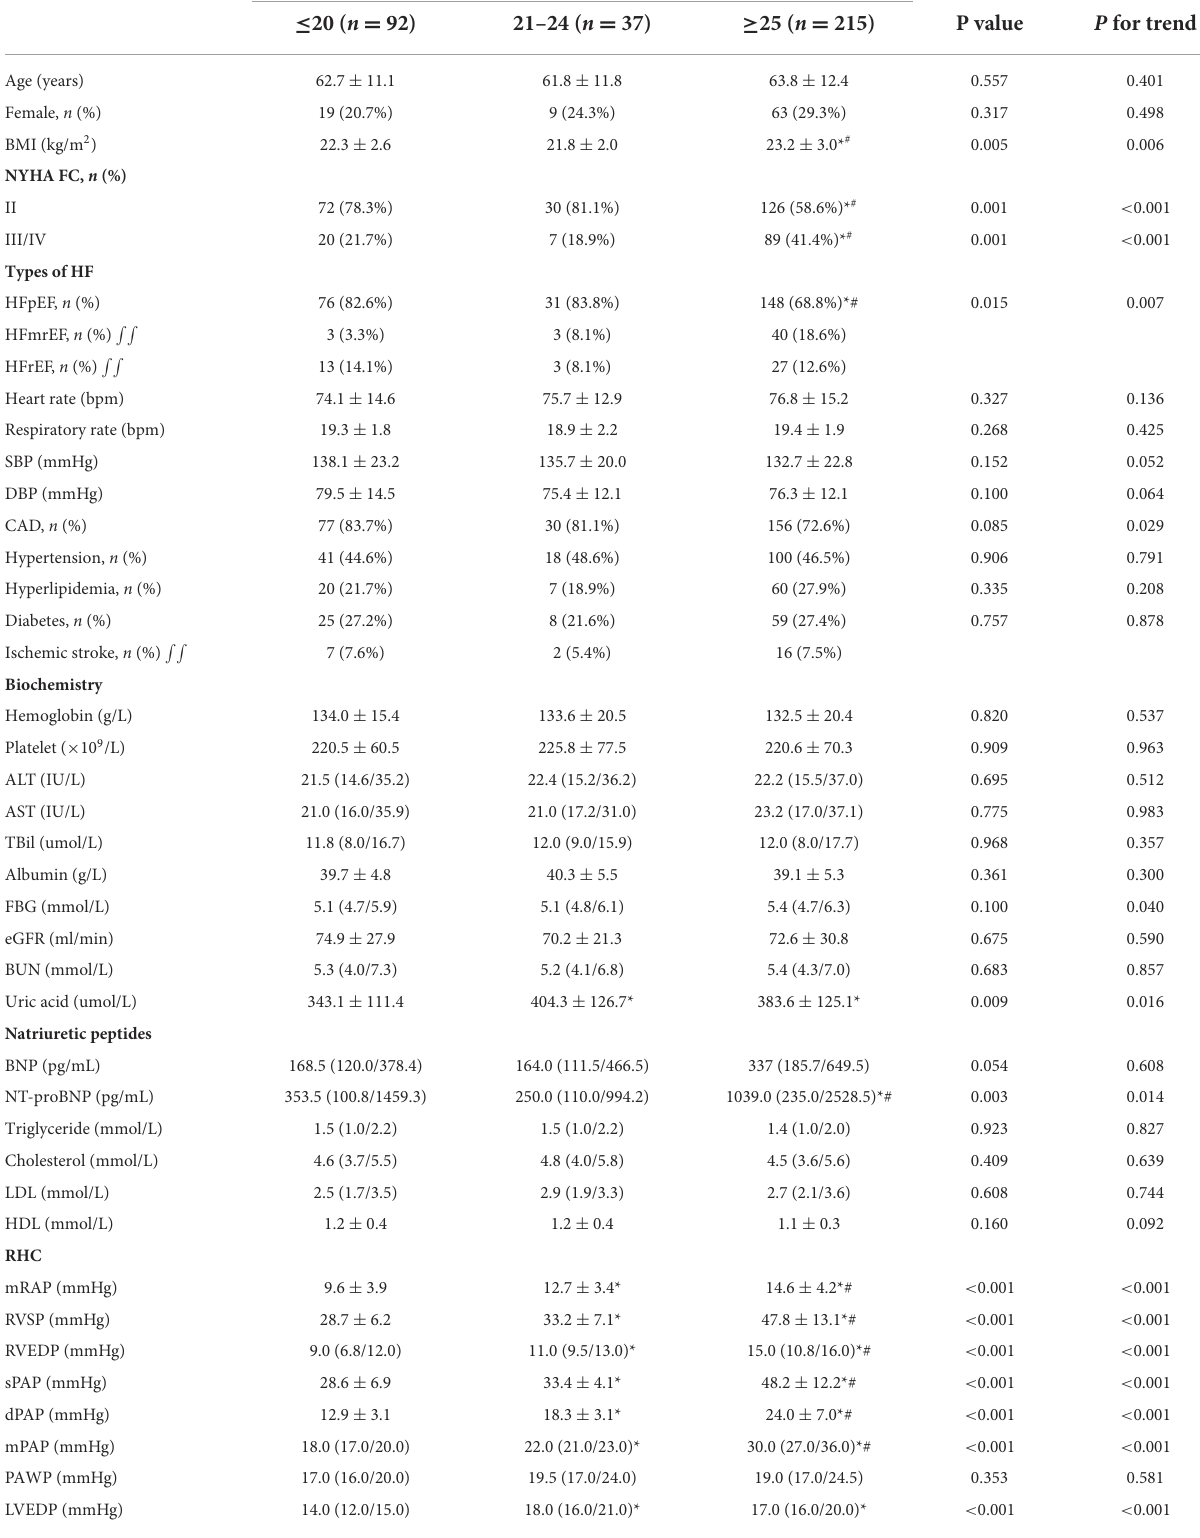
TABLE 1 Baseline demographic, clinical and hemodynamic characteristics by non-PH, borderline PH, and traditionally defined PH